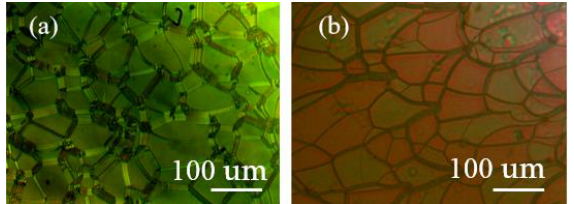
Figure 5. The surface morphology of ( a ) PS-CLC and ( b ) T-CLC.